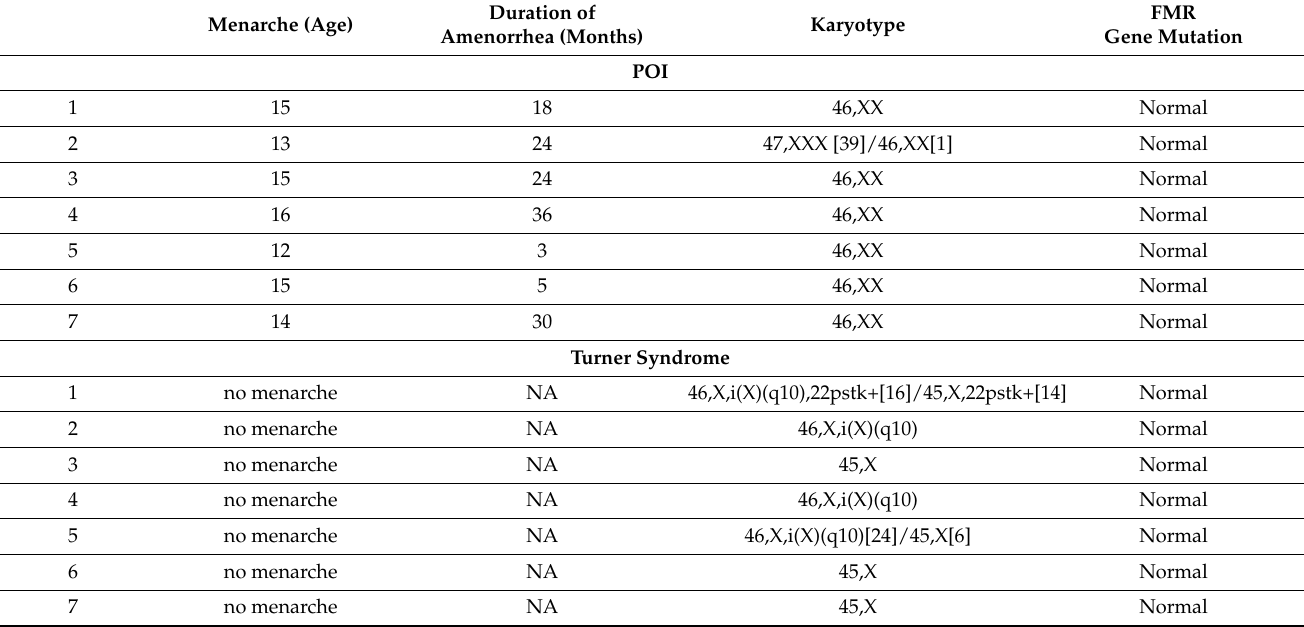
Table 3. Menstrual history of the patients and serum chromosomal analysis of both premature ovarian insufficiency and Turner syndrome groups in the sequencing